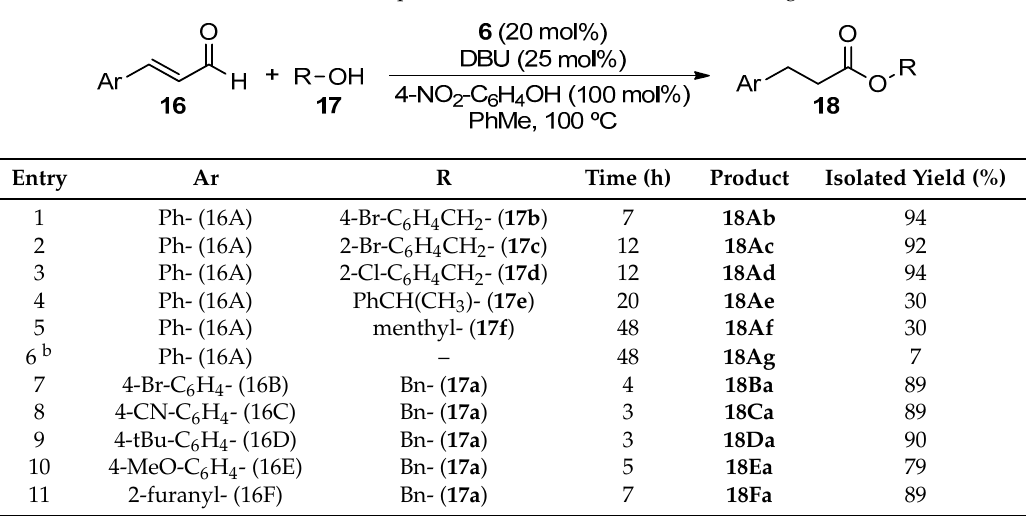
Table 5. Substrate scope of redox esterification reactions using 6 a .